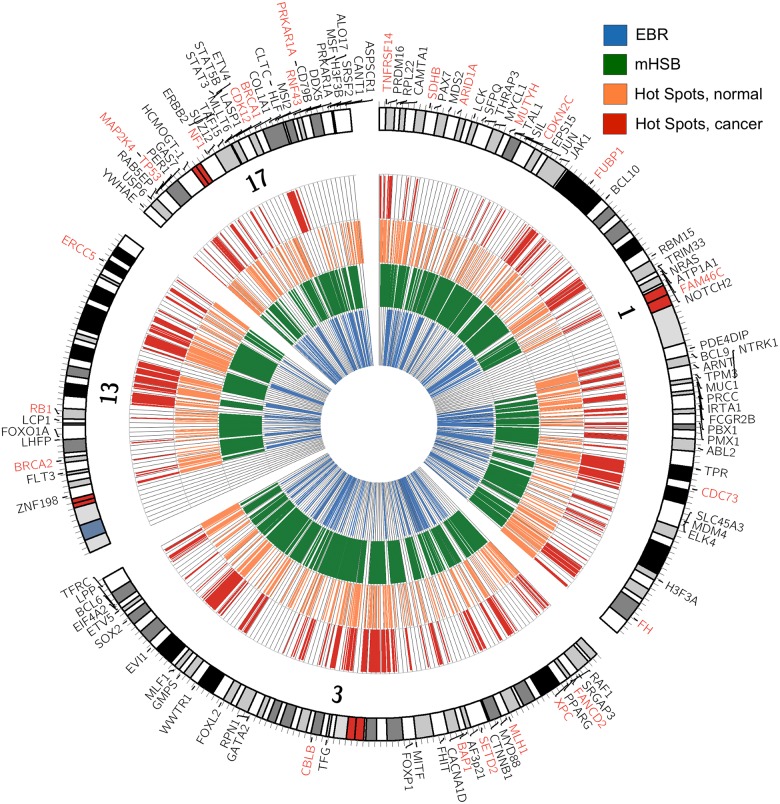
The genomic distribution of SNV clustering differs between normal and cancer.Circos plot showing distribution of SNV clustering for chromosomes 1, 3, 13 and 17. Tracks from inside out are: blue, evolutionarily re-used breakpoint regions (EBR); green, amniote homologous synteny regions (mHSB); orange, hot spots of CM clusters in normal; and red, hot spots of CM clusters in cancer. Outside text track are symbols for COSMIC genes in their corresponding genomic locations. Dominant genes are in black fonts and recessive genes are in red font.